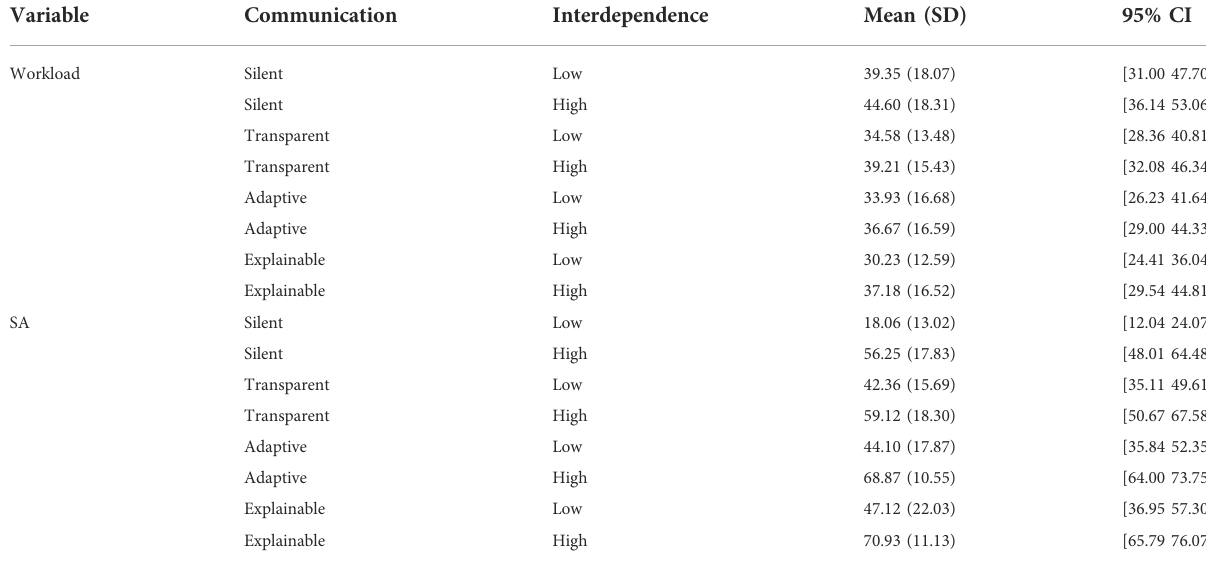
TABLE4Descriptivestatisticsforthedependent variablesworkloadandsituationawareness(SA).Valuescorrespondtothedatapointsoftheplotsin Figures